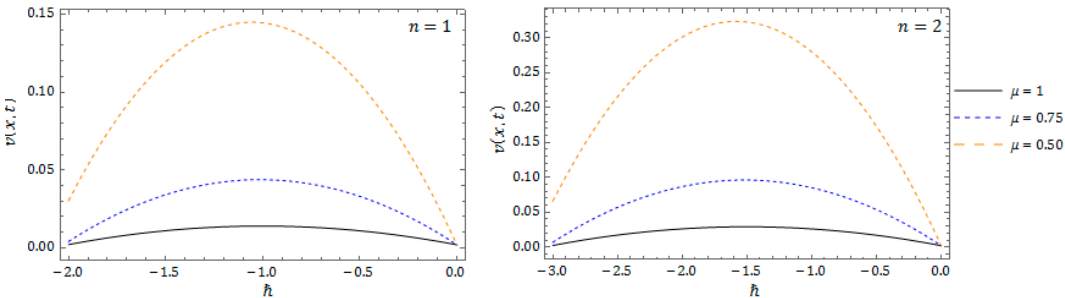
Figure 7 . Response of 𝑞 -HATM solution 𝑣(𝑥, 𝑡) in case (𝑖𝑖𝑖) with respect to 𝑡 at ℏ = −1, 𝑛 = 1 , and 𝑥 = 1 for diverse 𝜇.